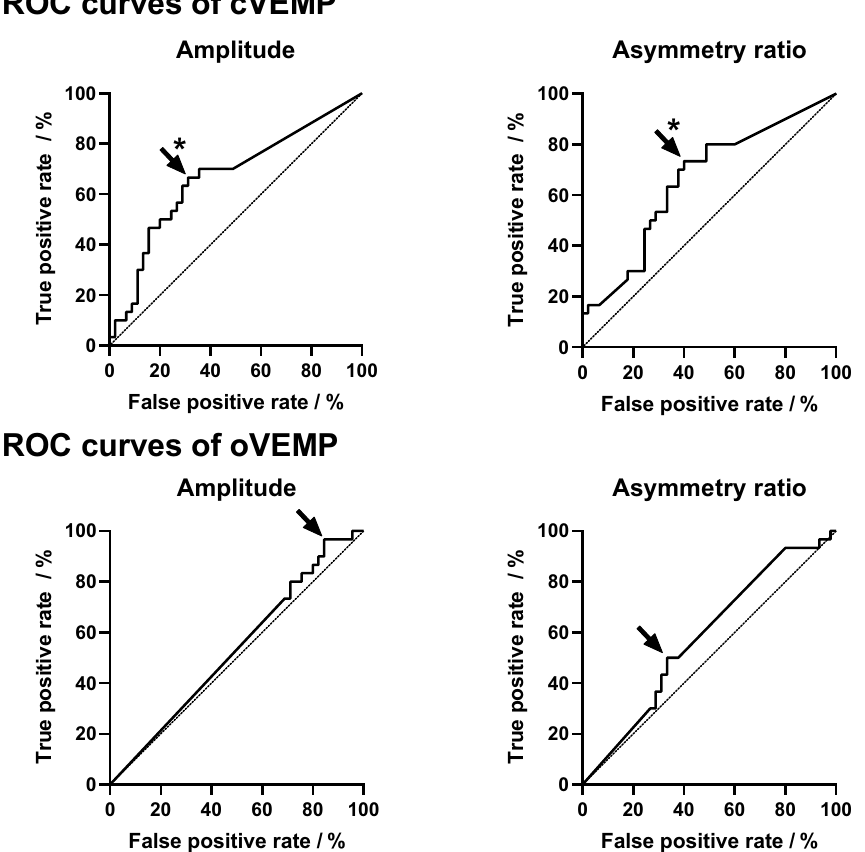
Figure 4. ROC curves for nerve of origin analysis based on cVEMP and oVEMP amplitude and asymmetry ratio measures. The diagonal marks random classification. Asterisks (*) mark significant areas under curve (p < 0.05). Arrows mark the optimized decision value.